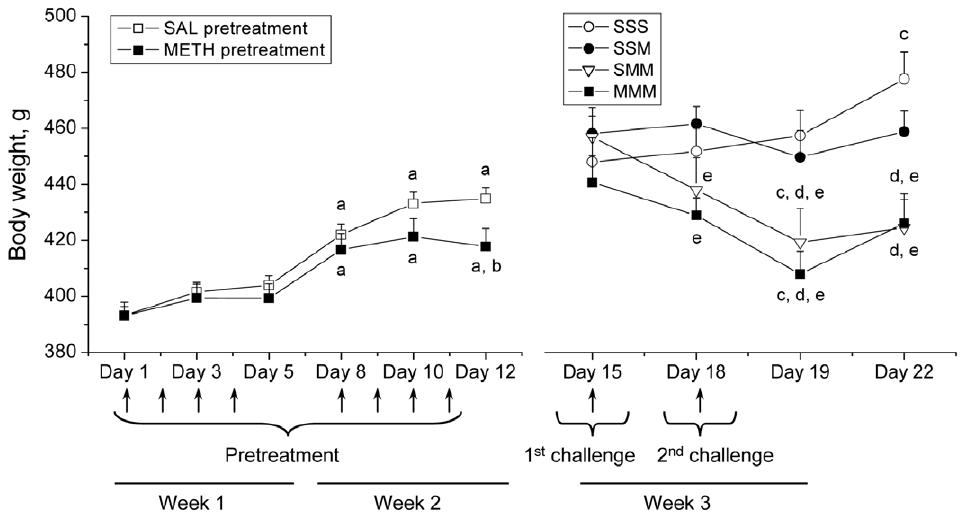
Figure 1. Methamphetamine administration causes decreases in body weights in the rat. (A) Rats pretreated with saline and METH showed increases in their body weights on Days 8, 10 and 12 in comparison to Day 1, with the METH group gaining significantly lower weights by Day 12. (B) On day 15, The saline-pretreated group was then divided into 3 groups that received saline challenges (SSS) or a single (SSM) or two METH challenges (SMM). The SSS group continued to gain weight after two saline challenges given on Day 22. However, rats challenged once with METH (SSM group) did not show significant changes in their body weights. In contrast, animals challenged twice with METH (SMM and MMM groups) showed reduction of their body weights in comparison to SSS and SSM groups on Days 19 and 22. The arrows indicate the day of saline or METH injections. Values are expressed as means 6 SEM. (N=6–32 animals per group). Key to statistics: a p , 0.05 in comparison to Day 1; b p , 0.05 in comparison to saline-pretreated group; c p , 0.05 in comparison to Day 15; d p , 0.05 in comparison to SSS group; e p , 0.05 in comparison to SSM group.